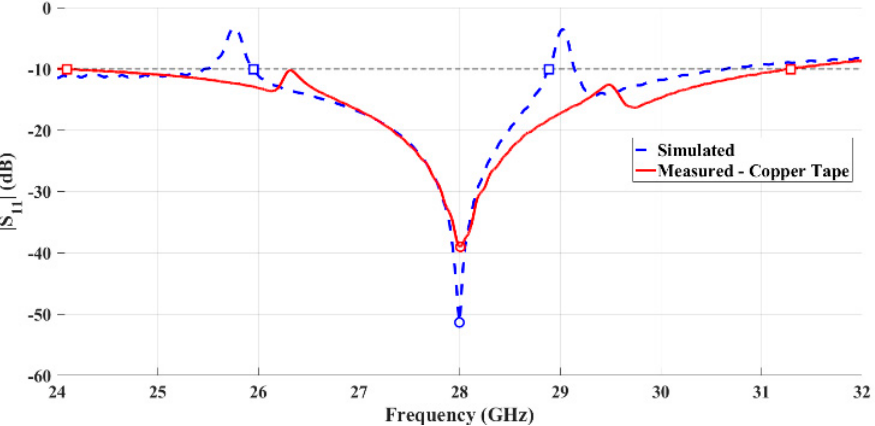
Figure 6. Comparison between simulated and measured reflection coefficient of the fabricated horn antenna using copper tape.